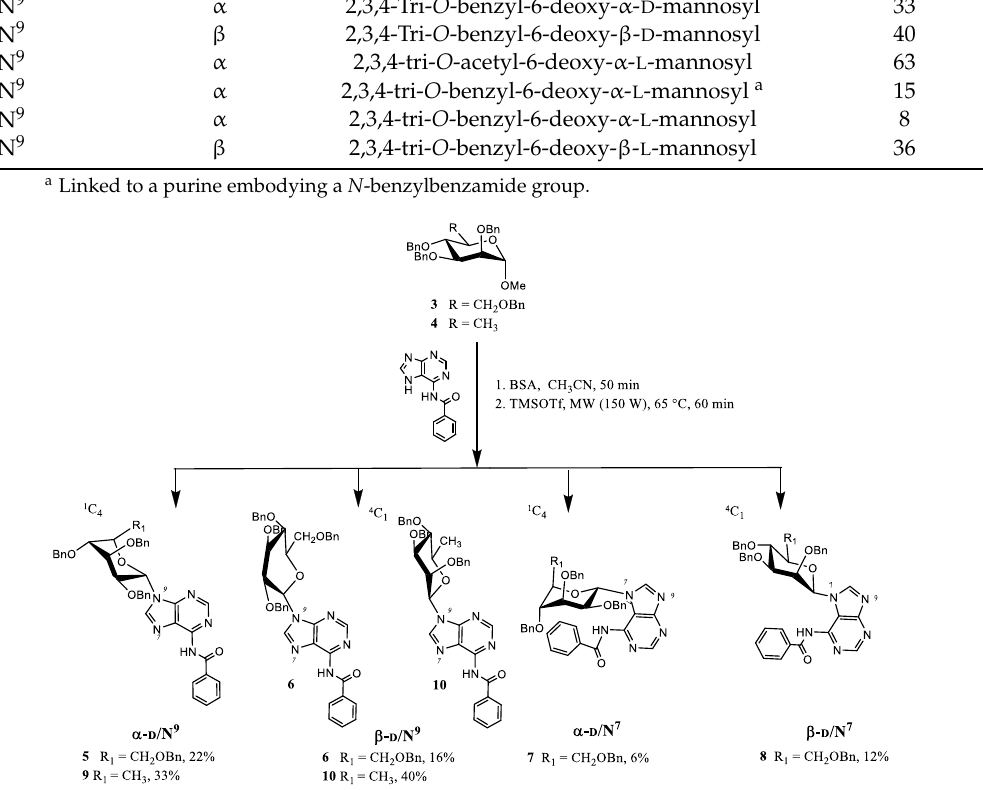
Scheme 1. Synthesis of nucleosides 5 - 10 , obtained by microwave-assisted reaction of glycosyl do- nors 3 or 4 with activated purine base catalyzed by TMSOTf, with conformations as deduced by NMR data and computational studies.